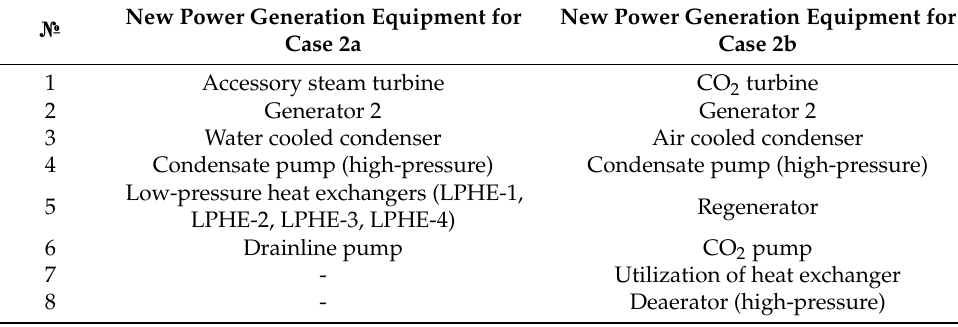
Table 6. New power generation equipment for modification of TPPs with BPSTs.